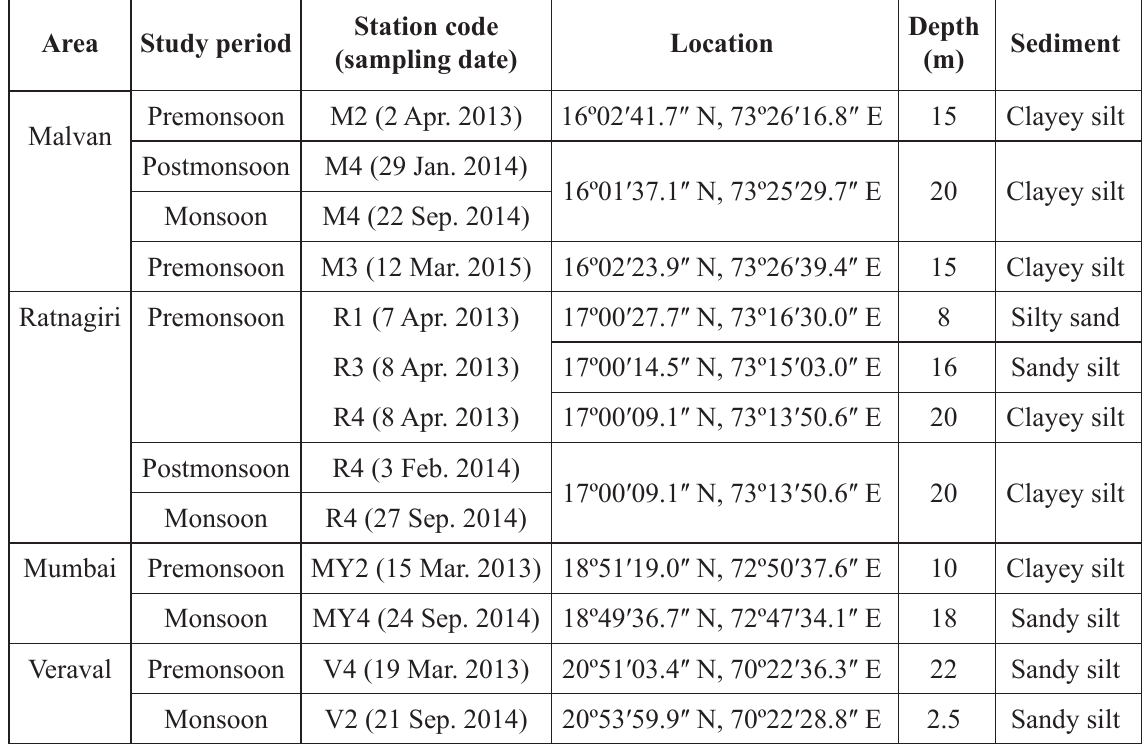
Table 1. Details of sampling locations off the west coast of India where specimens of Heterospio indica sp. nov. were